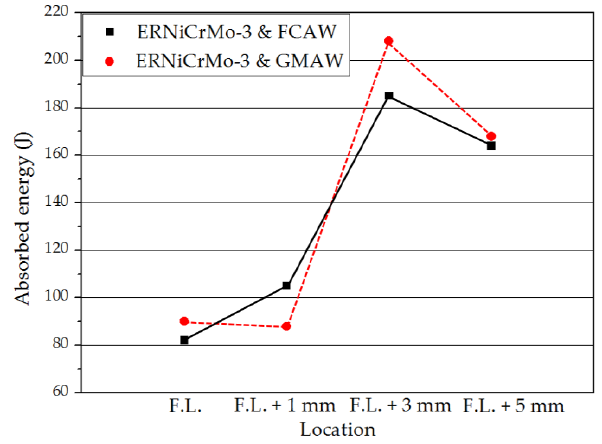
Figure 6. Charpy-V impact test results for various locations of the HAZ [13].